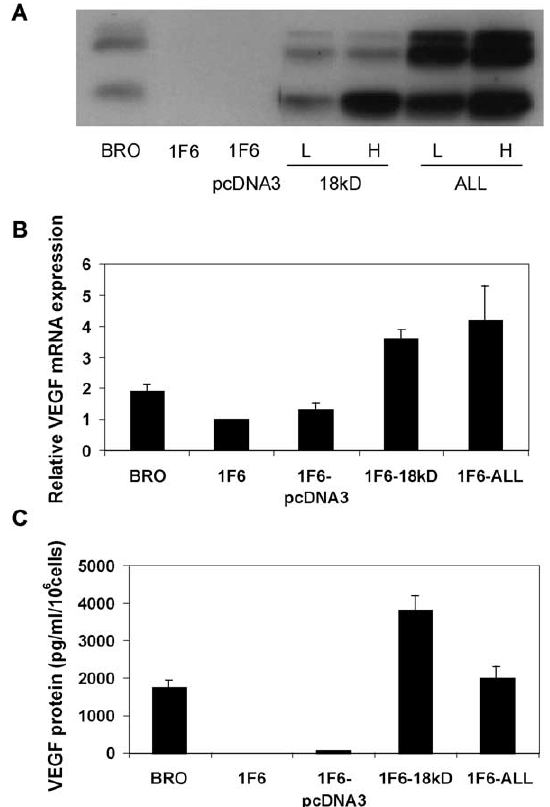
Fig. 1. bFGF overexpression in 1F6 cells and the effect of bFGF overexpression on VEGF mRNA expression and protein secretion in BRO, 1F6, 1F6-pcDNA3 and clones highly (H) or lowly (L) over- expressing the 18 kD form or all forms of bFGF. (A) bFGF pro- tein expression was determined by subjecting 25 µg protein of each cell line to Western blot. (B) Cells were serum-starved for 24 h, to- tal RNA was isolated and VEGF mRNA levels were determined by light cycler RT-PCR. Relative VEGF expression in 1F6 cells was set at 1. (C) VEGF protein expression in conditioned medium was deter- mined by ELISA. BRO was included as a positive control cell line. Light cycler and ELISA results are shown as mean values ± range of duplicate samples. The experiments were performed three times with similar